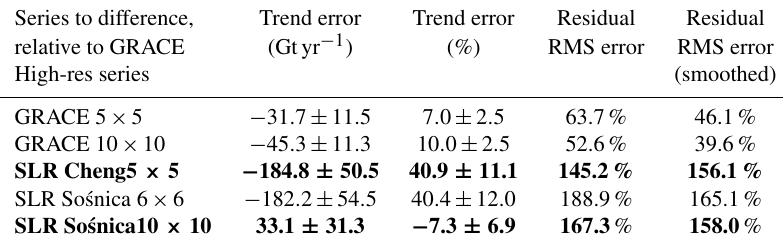
Table 1. Differences relative to GRACE 60 × 60 high-resolution, local inversion, over the combined Greenland/Antarctica region during 2003–2014. Residual RMS errors are those after the trend has been removed, relative to the GRACE 60 × 60 detrended RMS. The final column is the residual RMS error after a 13-month Gaussian filter has been applied to all series. Errors given are at purely statistical 95% confidence levels after fitting for a bias, trend, annual, and semi-annual signals, based on a Monte Carlo simulation of random red noise with the given RMS and lag-1 autocorrelations. They do not include the intrinsic errors of the satellites themselves or the effects of the inversion method. Errors are computed on series including only those months estimated by GRACE. Series to difference, Trend error Trend error Residual Residual relative to GRACE (Gtyr − 1 )